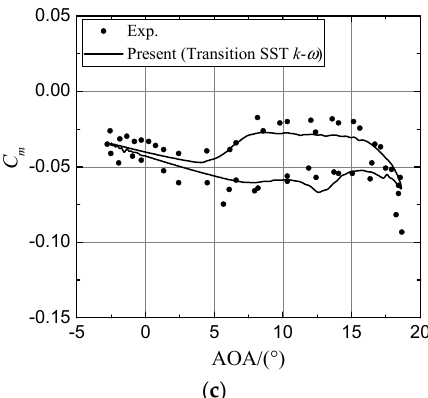
Figure 5. Aerodynamic coefficients in light stall of the NREL S809 airfoil under pitch oscillation. α mean = 8 ◦ , A = 10 ◦ , k = 0.026, and Re = 1 × 10 6 : ( a ) C l ; ( b ) C d ; ( c ) C m .